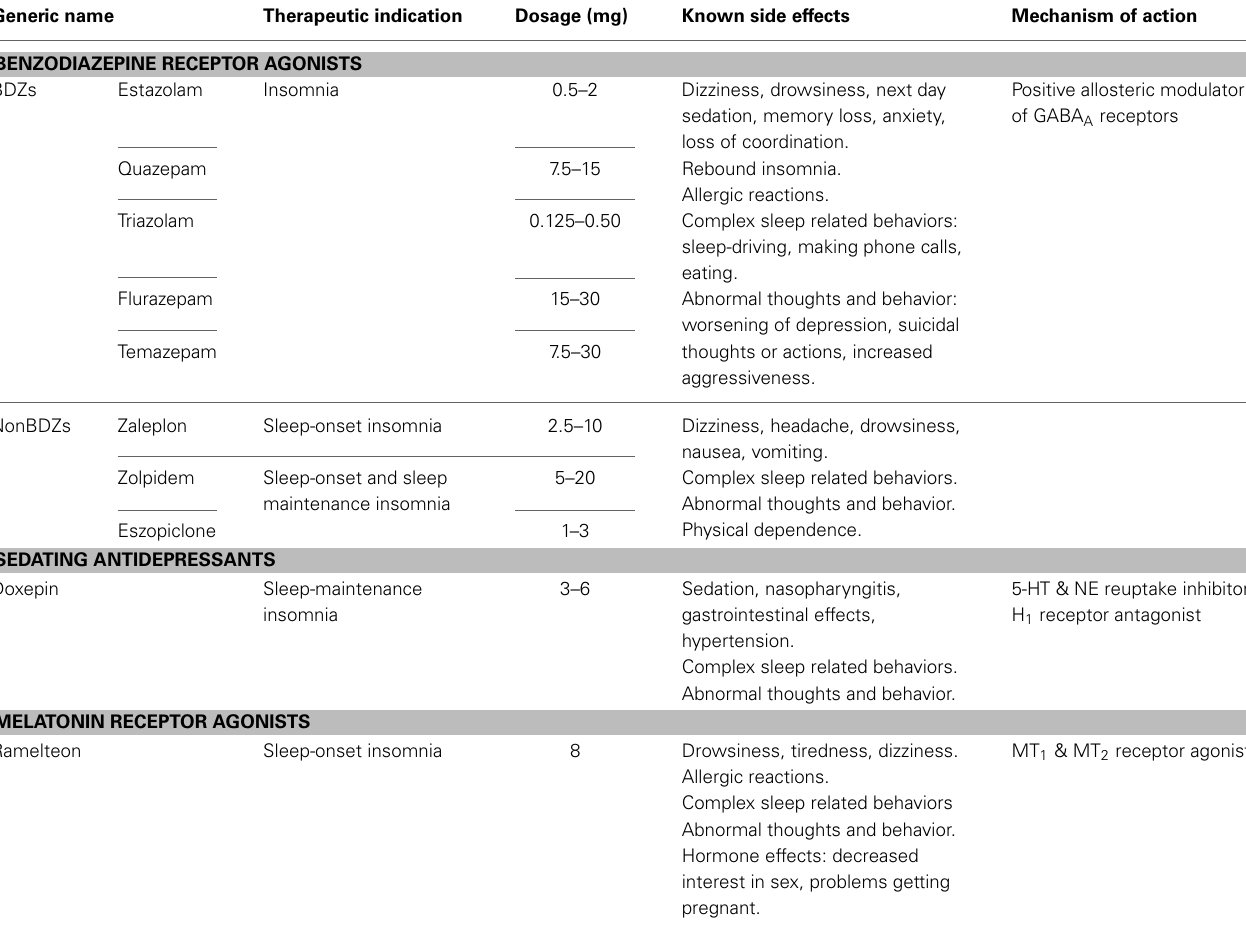
Table 1 | FDA approved medications for the treatment of